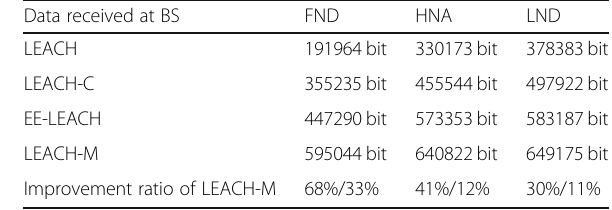
Table 8 The statistics of received data at BS of four algorithms